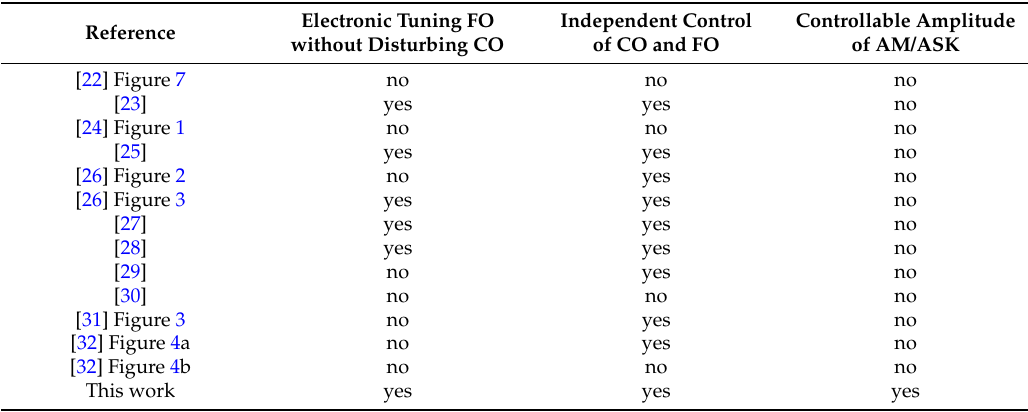
Table 2. Characteristic comparisons with previous third-order